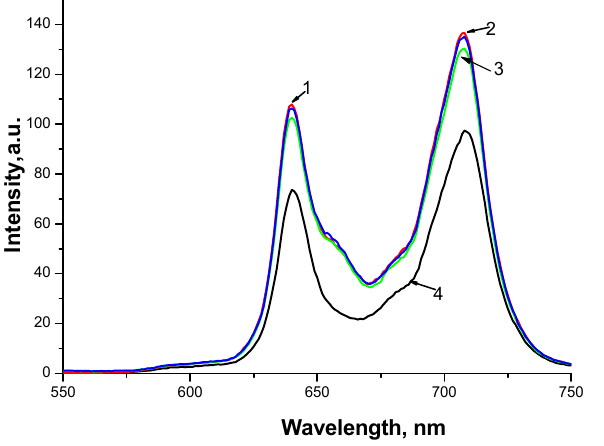
Figure 7. Fluorescence spectra for TPPF20-F127 in water (1, red), in the presence of chitosan (2, blue) and acetic acid 0.2% (3, green), in chloroform (4, black). The concentrations: C TPPF20 = 5 × 10 − 6 M, C CT100 = 6 × 10 − 4 M, C F127 = 10 − 4 M.